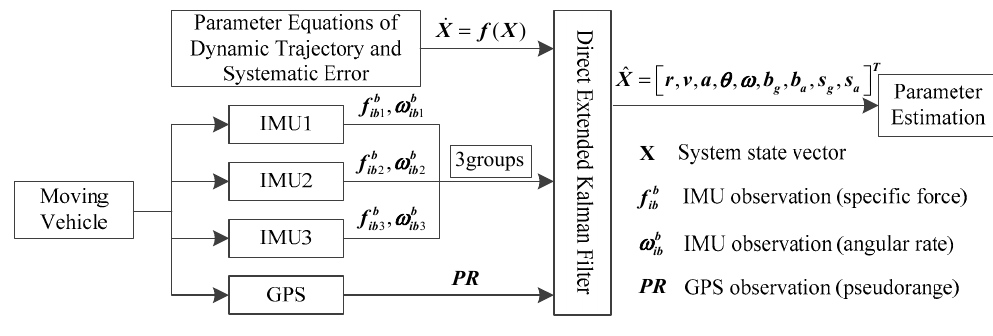
Figure 2. Unconventional integration mechanism.